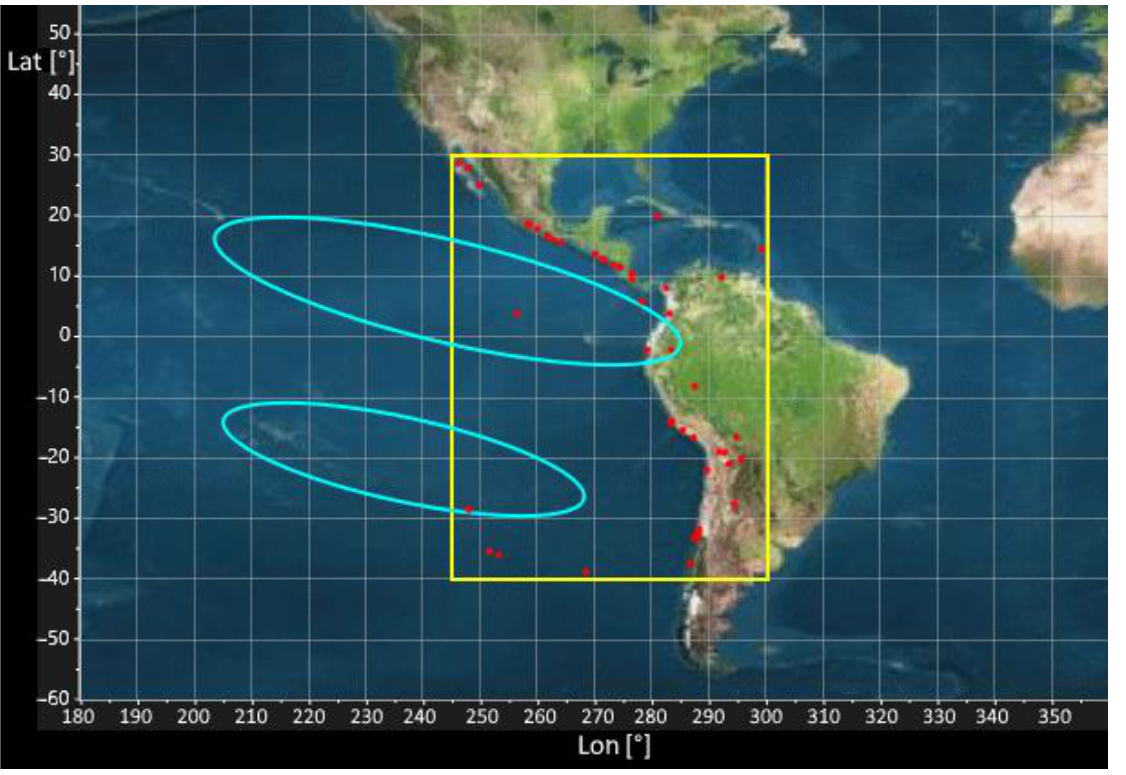
Figure 5. The very large area of EQ epicenters that contributed to the correlations in Figure 2 is delimited by yellow lines, EQ positions are reported by red dots, and cyan contours delimitate the region where the NOAA satellite detected EBs correlated with EQs.